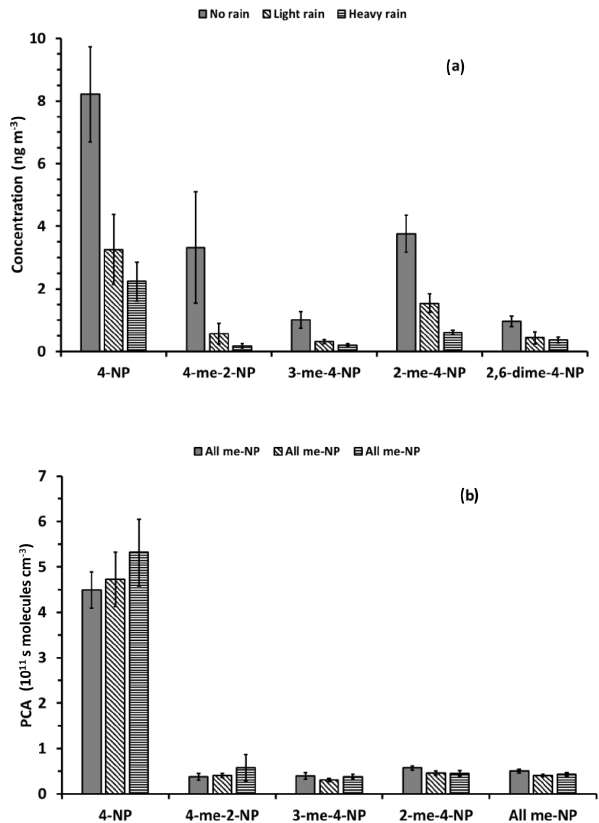
Figure 7. Average nitrophenol concentrations (a) and PCA (b) de- termined from carbon isotope ratios reported by Saccon et al. (2015) using Scenario 3 for different precipitation conditions during and before sampling. No rain refers to a total precipitation of less than 1mm on the day of sampling and the day before; light rain refers to between 1 and 10mm precipitation on the day of sam- pling or a total of > 4mm on the day of sampling and the day be- fore; and heavy rain refers to > 20mm precipitation on the day of sampling or > 10mm on the day of sampling and > 20mm on the day before. Historical meteorological data were acquired from Environment Canada, Toronto North York site (http://climate. weather.gc.ca/historical_data/search_historic_data_e.html, last ac- cess: 23 April